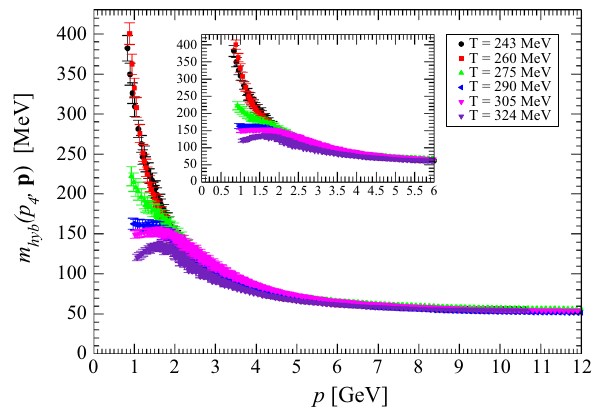
Fig. 10 The running quark mass m h ( p 4 , p ) for all the T and for the simulations using m bare ∼ 50 MeV. Only the data corresponding to the first Matsubara frequency is shown